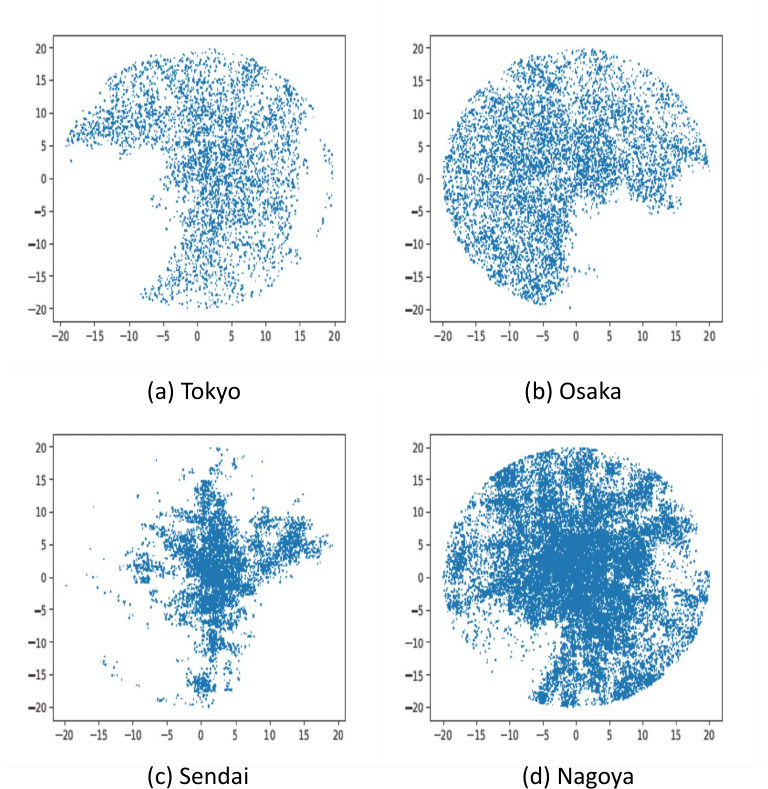
Figure 8. The four user distribution scenarios: ( a ) Tokyo, ( b ) Osaka, ( c ) Sendai, and ( d )